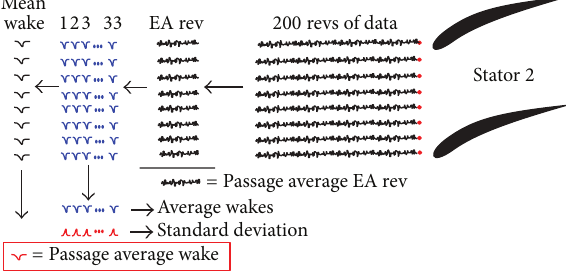
Figure 7: Data processing strategy for cross-film measurements acquired at rotor